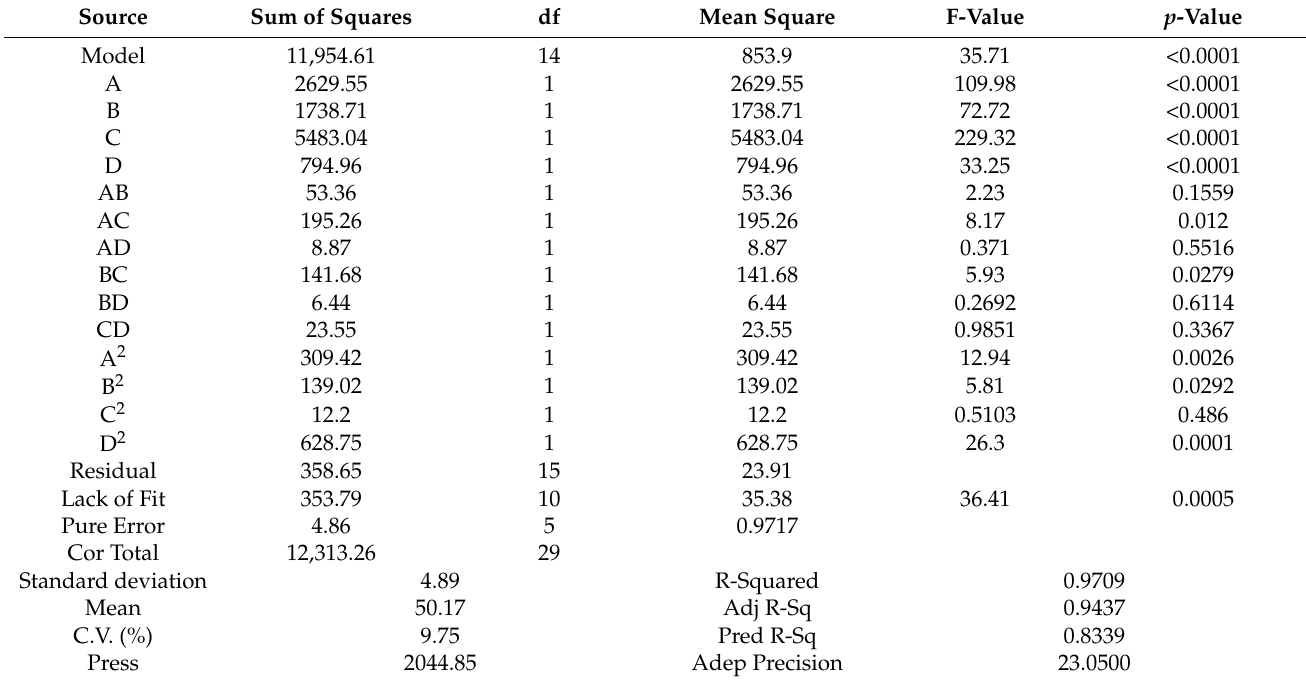
Table 5. The quadratic model of ANOVA analysis for the Mn leaching